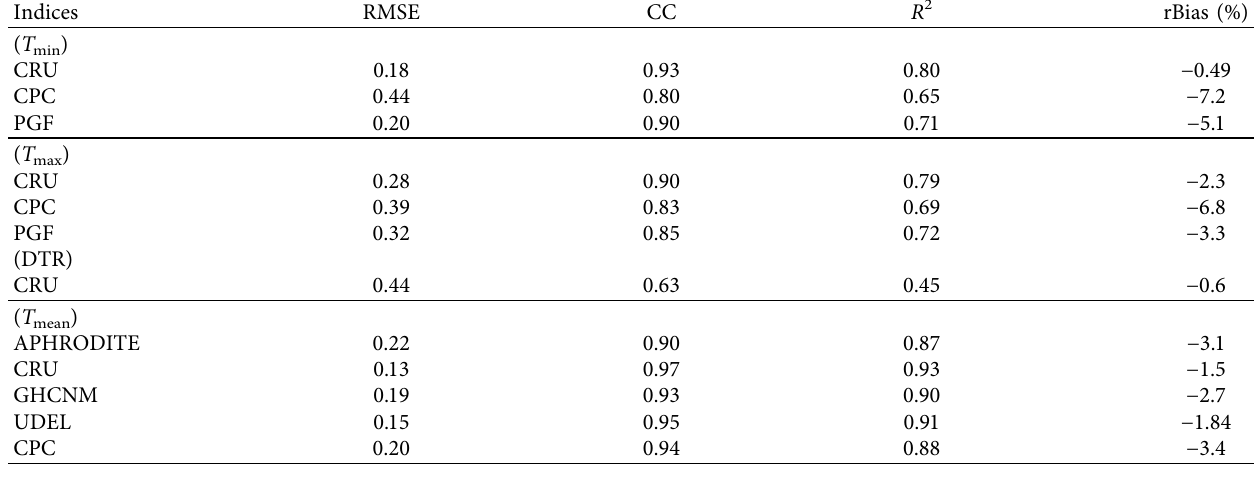
Table 2: Statistical metrics for the evaluation of temperature indices GDPs.